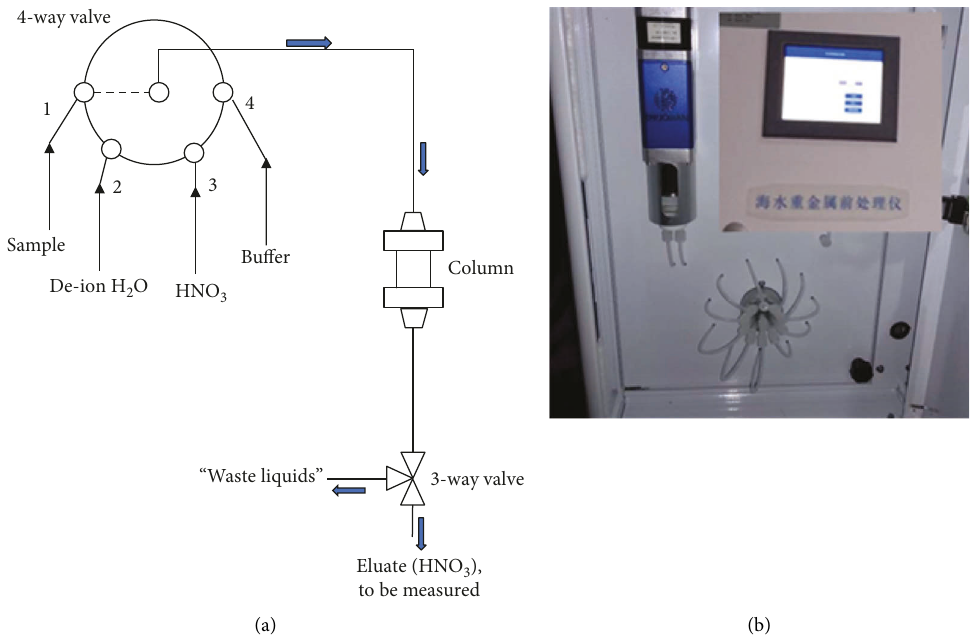
Figure 4: (a) Illustration of trace metal ion preconcentration system. (b) A digital photo of the laboratory that assembled the pre- concentration